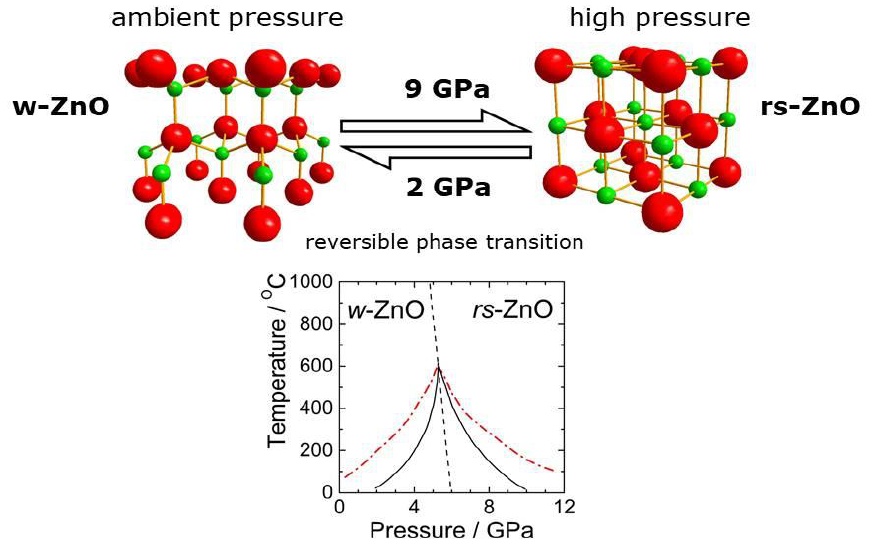
Figure 2. Direct and inverse phase transitions in ZnO [19] (black lines). Hypothetical hysteresis for nanocrystalline ZnO is shown by red lines.